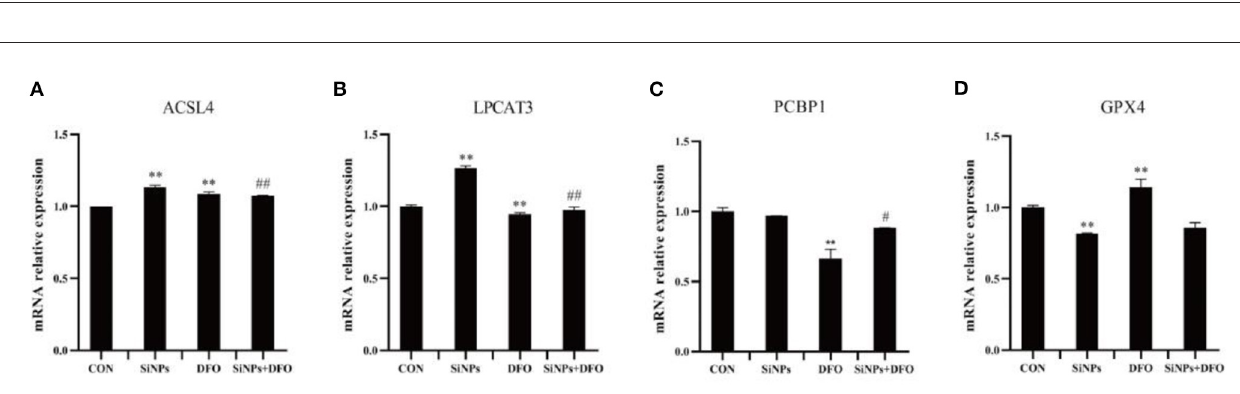
FIGURE2 The mRNA expression of key genes involved in ferroptotic pthway. (A) The relative mRNA expression of ACSL4. (B) The relative mRNA expression of LPCAT3. (C) The relative mRNA expression of PCBP1. (D) The relative mRNA expression of GPX4. [** p < 0.01, compared with the con; # p < 0.05, ## p < 0.01, compared with the SiNPs, n =